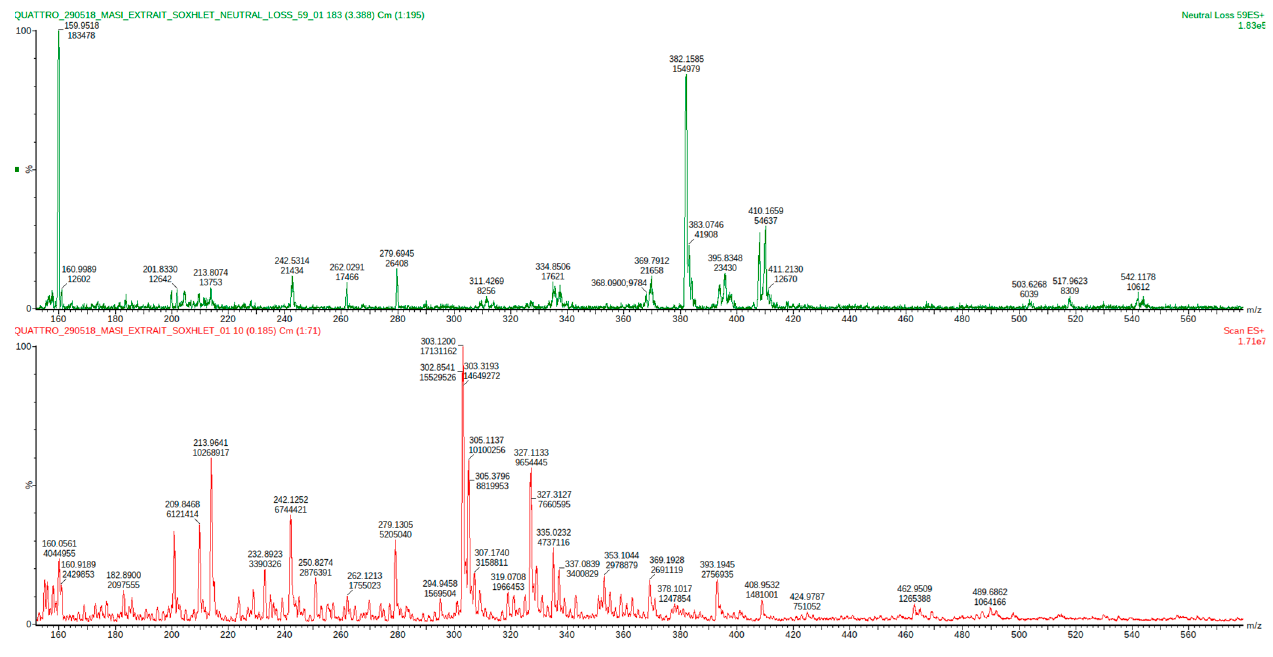
Figure 3. Mass spectrum of the HTMOB-derivatized carbonyl extract obtained from overcooked chicken meat by condensation with silica-gel supported reagent. ESI-MS full scan mode (below) and ESI-MS/MS neutral loss 59 Da mode (above). Table 1. Analysis of ESI-MS/MS neutral loss of 59 Da spectrum of the HTMOB- derivatized carbonyl extract obtained from overcooked chicken meat by condensation with silica-gel supported reagent. m/z of Major Peak in M